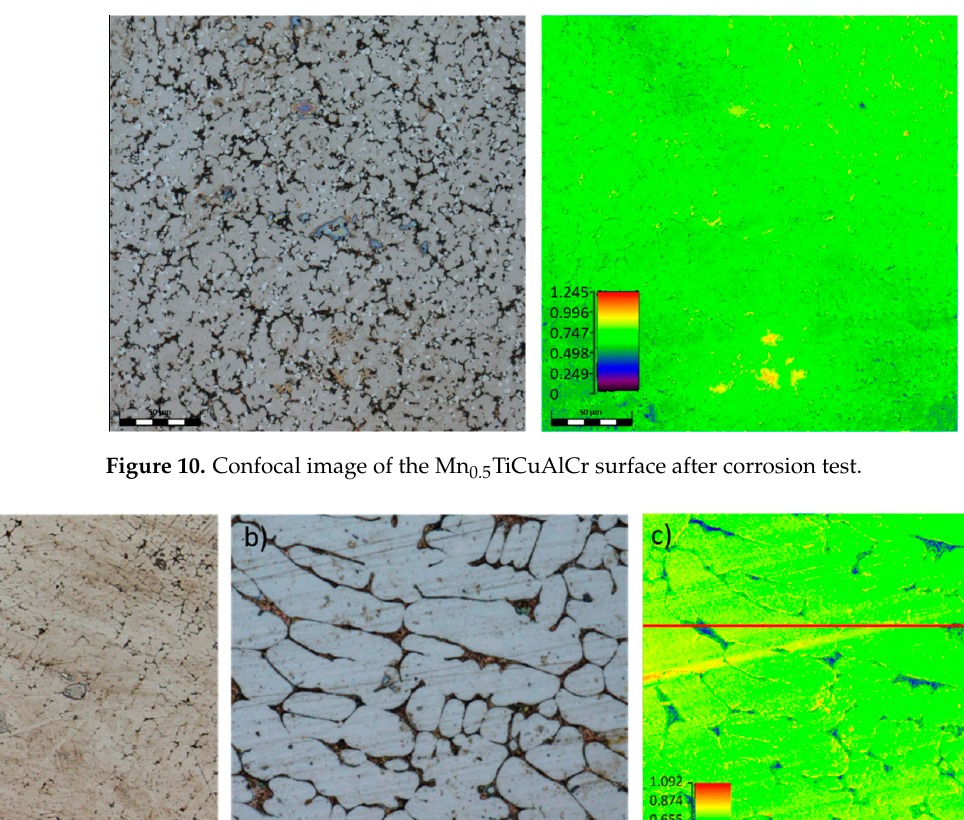
Figure 9. Confocal image of the Al 0.7 CoCrFeNi surface after corrosion test.